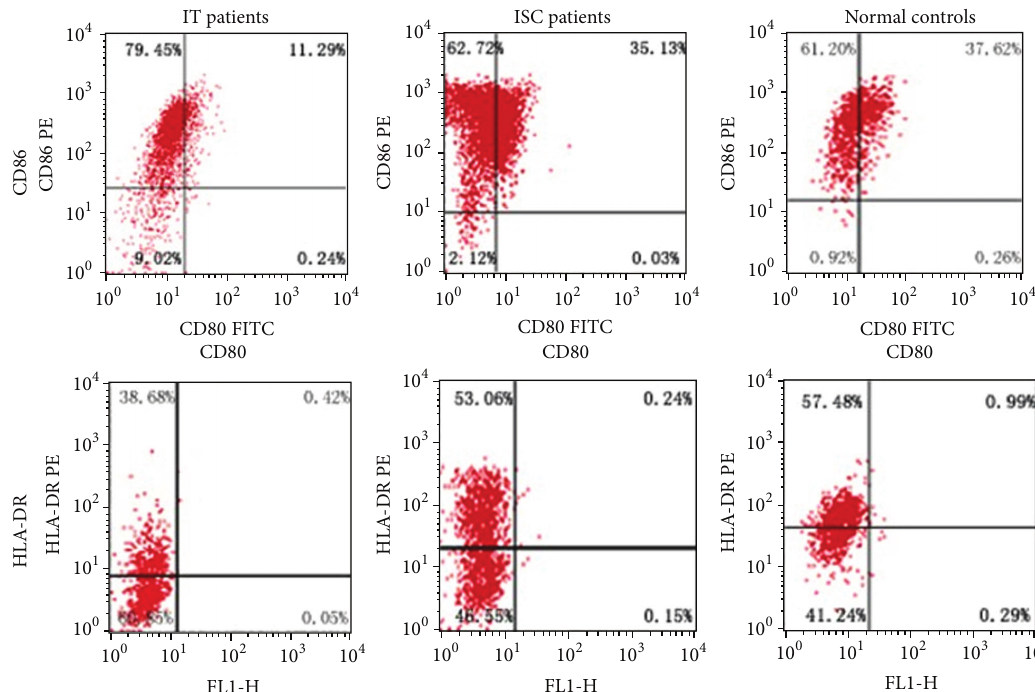
Figure 2: Expression of surface markers on dendritic cells cultured for 9 days.